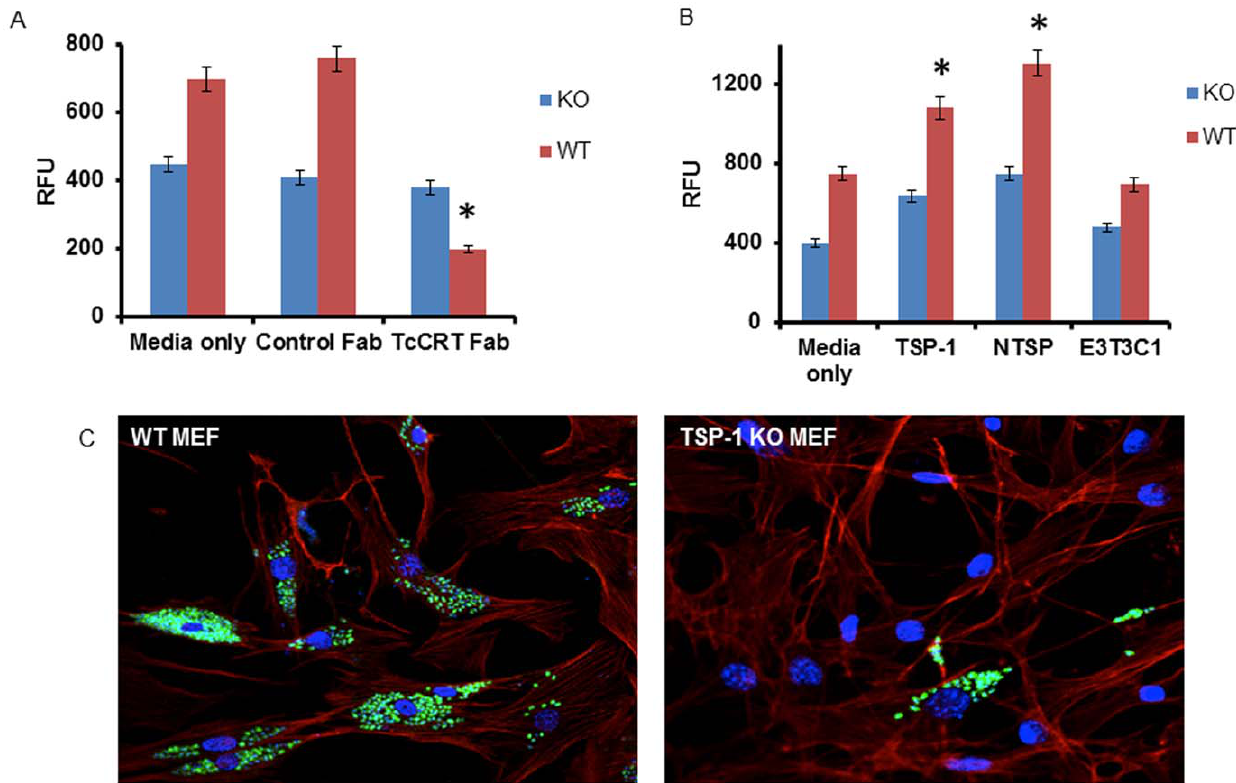
Figure 4. Roles of TcCRT and TSP-1 in cellular infection. A , TcCRT Fab blocks trypanosome cellular infection . Transgenic T. cruzi trypomastigotes expressing GFP were pretreated with either monovalent Fab fractions of anti-TcCRT or with monovalent Fab fractions of an isotype control and exposed to either WT or TSP-1 KO MEF for 72 hours. The infection was determined fluorimetrically. B , TSP-1 and NTSP enhance trypanosome infection but not E3T3C1. Pre-incubation of transgenic T. cruzi trypomastigotes expressing GFP with endotoxin free TSP-1 or NTSP enhances cellular infection of WT MEF compared to TSP-1 KO MEF. Pre-incubation of transgenic T. cruzi trypomastigotes expressing GFP with endotoxin free E3C3T1 does not significantly affect cellular infection of WT or TSP-1 KO MEF. Bars represent the means of results from triplicate samples of one representative experiment ( 6 1 S.D.) selected from three independent experiments with similar results. *Significant differences between WT and KO MEF (P , 0.05). C, The absence of TSP-1 expression reduces cellular infection. GFP expressing transgenic trypomastigotes exposed to TSP-1 KO MEF (Fig. 4C right panel) for 72 hours sustained less infection than WT MEF (Fig. 4C left panel), as observed by fluorescence microscopy. Cell monolayers were stained with DAPI (blue nuclei), Alexa fluor 546 phalloidin (red actin myofibrils) and parasites expressing GFP are seen in the cytoplasm. This is a representative experiment of three independent experiments performed with similar results.